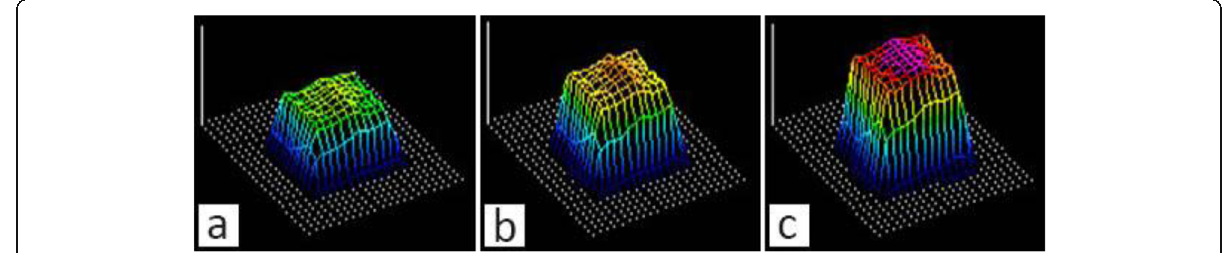
Fig. 8 Example of the pressure contour at different sensitivity levels: a low sensitivity (S17), b optimal sensitivity (S19), c oversaturation